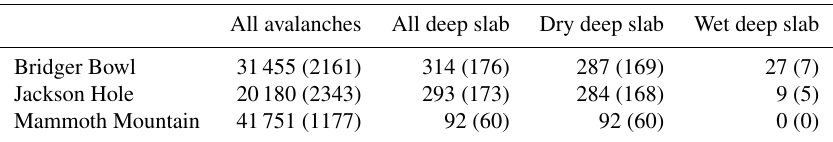
Table 5. Summary of number of total avalanches, all deep slab events, dry deep slab events, and wet deep slab events. The number of days each type of avalanche was recorded is given in